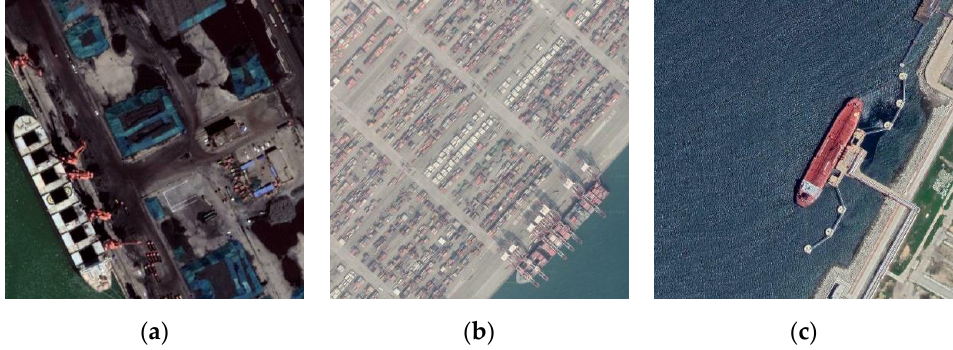
Table 2. The number of cargo ships used per category after applying augmentation techniques.